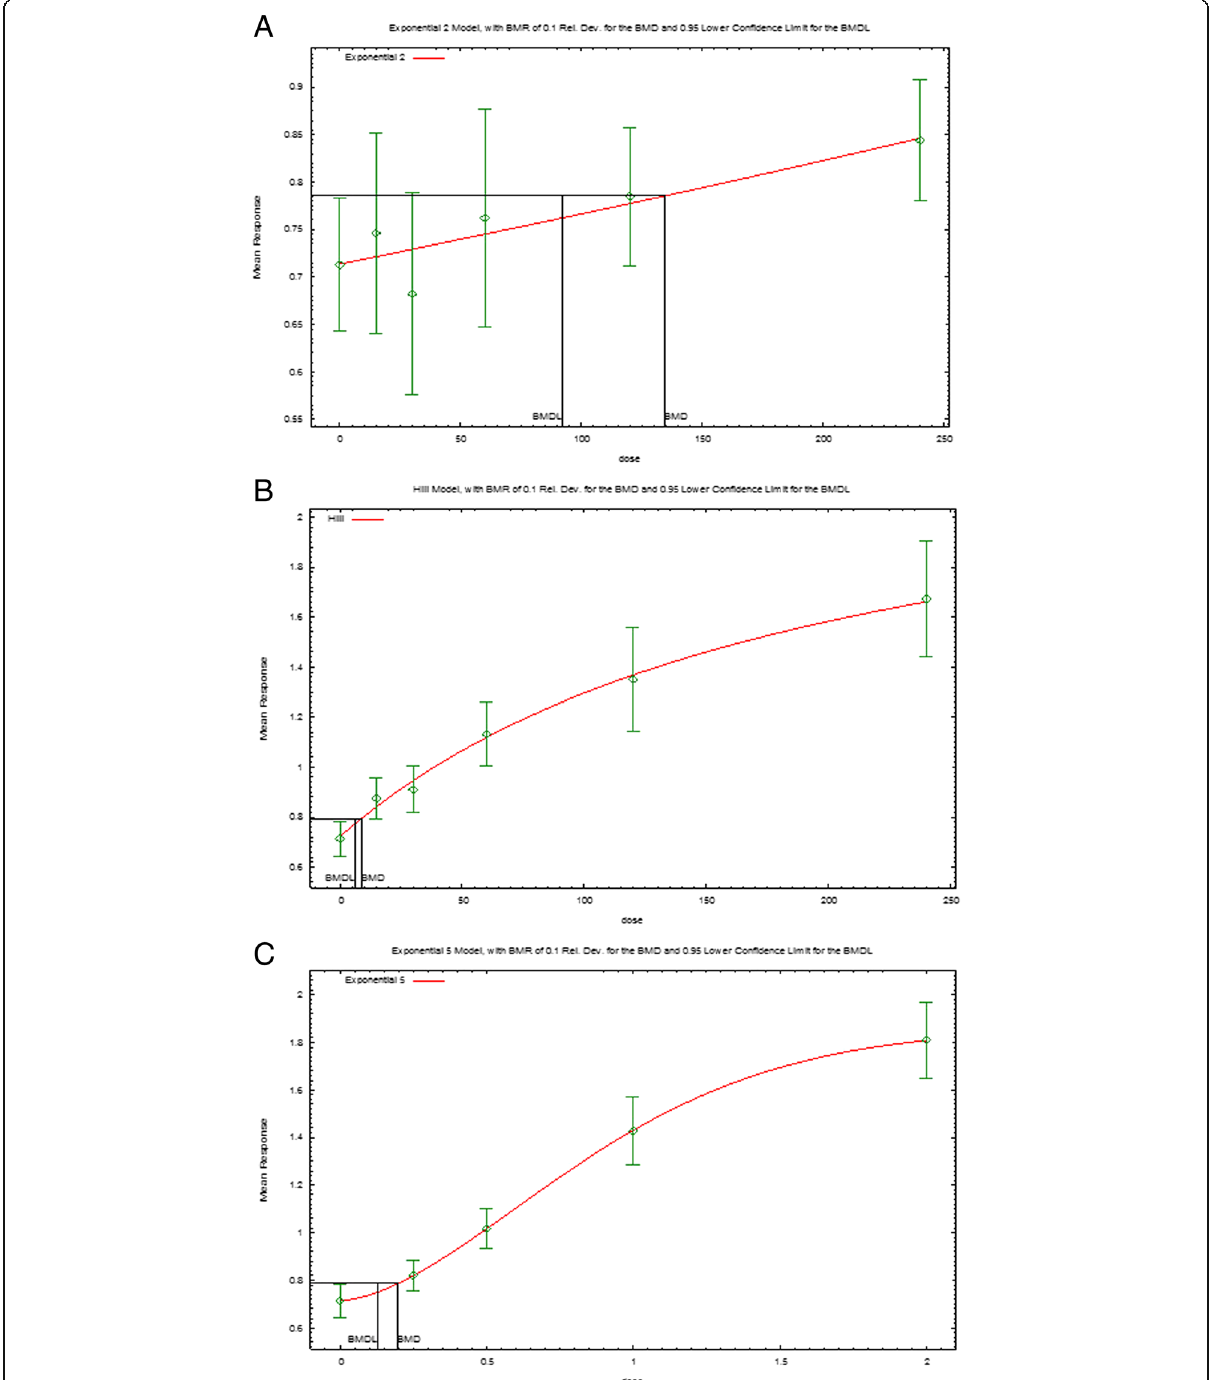
Fig. 7 Models of the dose-response relationship of the uterus/body weight ratio simulated for the individual chemicals. a . Exponential model for BPA, b . Hill model for NP, c . Exponential model for